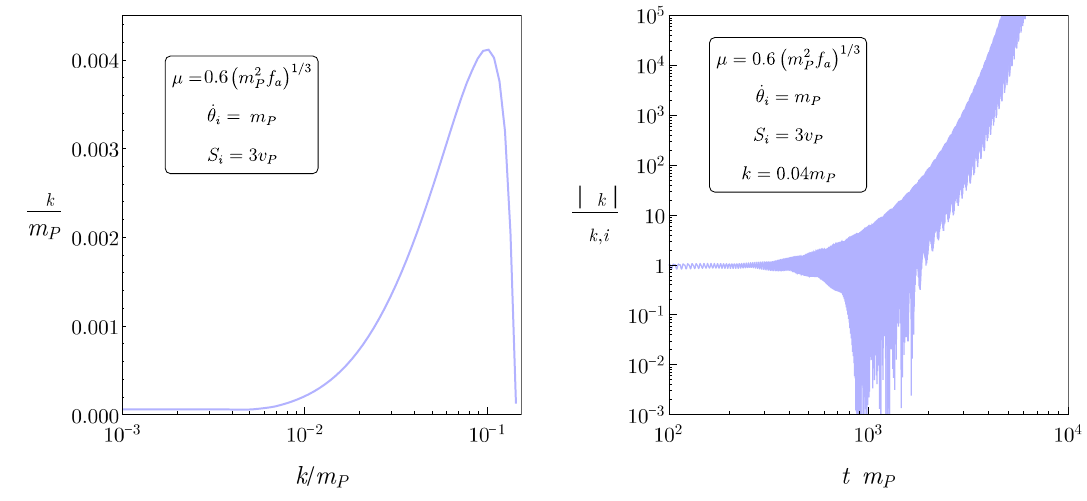
Figure 5 . Growth of axion fluctuations due to parametric resonance. The left panel shows the growth rate µ k as a function of the momentum mode k both in units of m P . The right panel shows the solution of the fluctuation θ k normalized to the initial value θ k,i as a function of